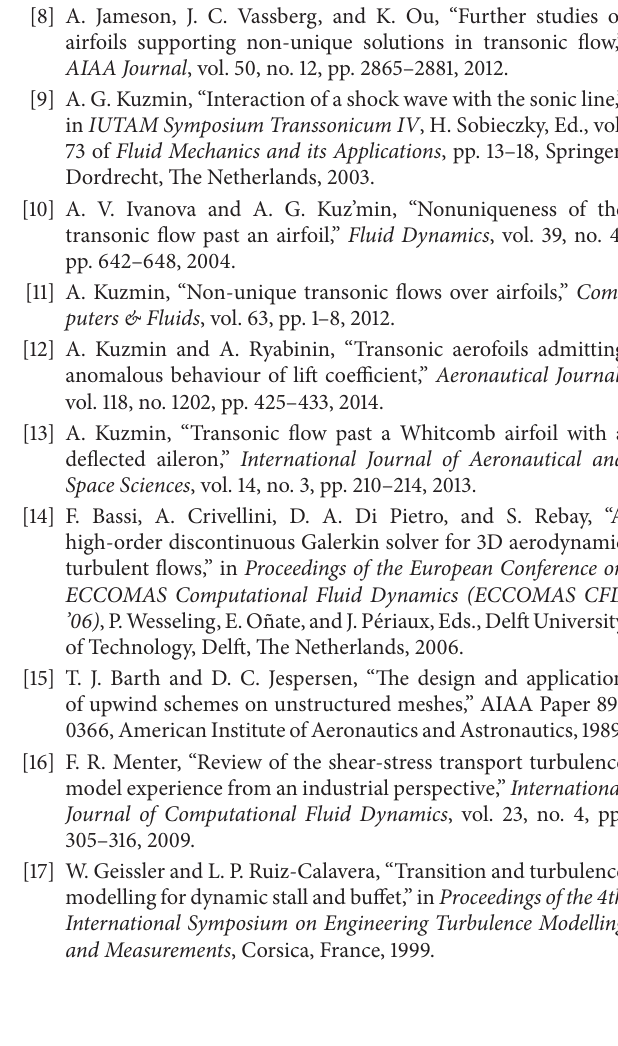
edges of the wings. The sensitivity is expected to be even higher for larger wing